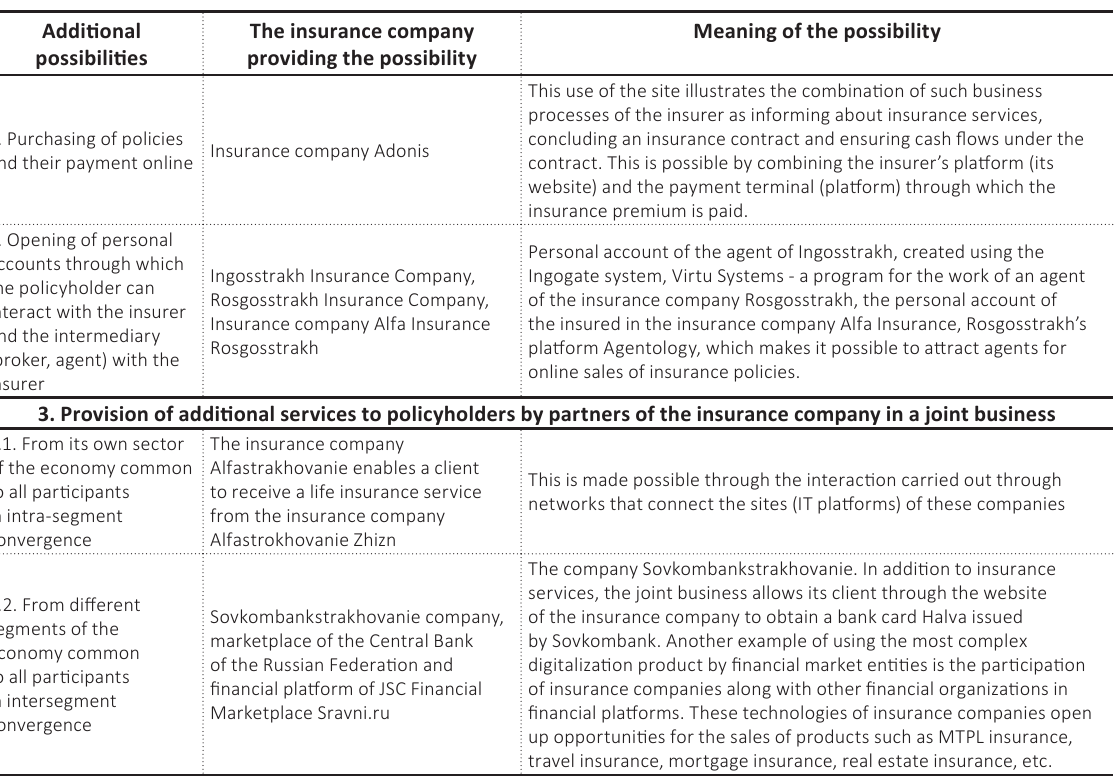
Table А2. Additional opportunities provided by the third stage digitalization product (IT, IT platforms and